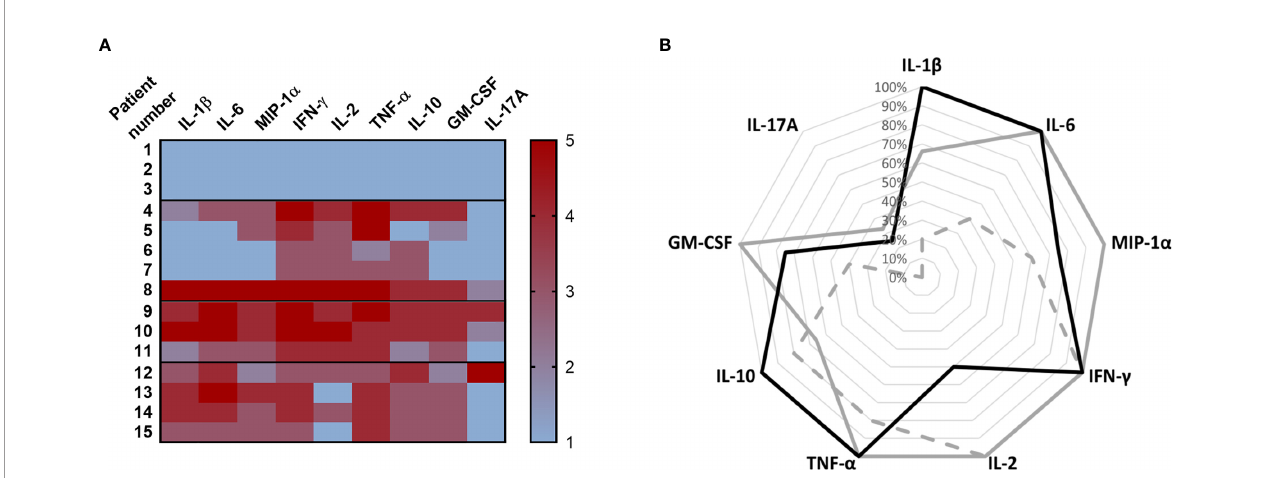
FIGURE 5 | HBHA-induced cytokine/chemokine pro fi les. PBMC from 3 different groups of patients were in vitro stimulated with HBHA during 24 h and cytokines/ chemokines were measured in the culture supernatants using a multiparameter based immunoassay. (A) Heat-map of the HBHA-induced cytokine/chemokine secretions. Three TST − patients (patient n°1 to 3) were included in parallel to 5 TST + QFT + patients (patient n°4 to 8), 3 TST + QFT − patients (patient n°9 to 11) and 4 TST − QFT - but HBHA + patients (patient n°12 to 15). A color scale representing the intensity of the cytokine/chemokine concentrations was established for each analyte from negative values (1, blue) to doubtful (2, pink), low and strong cytokine/chemokine concentrations (3 to 5, from light red to dark red). (B) Radar chart of the HBHA-induced cytokine/chemokine pro fi les indicating the percentages of patients within each group secreting IL-1 b , IL-6, MIP-1 a , IFN- g , IL-2, TNF- a , IL-10, GM-CSF and IL-17A at concentrations higher that the upper limit of the grey zone around the de fi ned cut-off value. TST + QFT + HBHA-IGRA + patients are represented by the dotted line (n=5), TST + QFT − HBHA-IGRA + patients are represented by the grey line (n=3), and TST − QFT − HBHA-IGRA + patients are represented by the black line